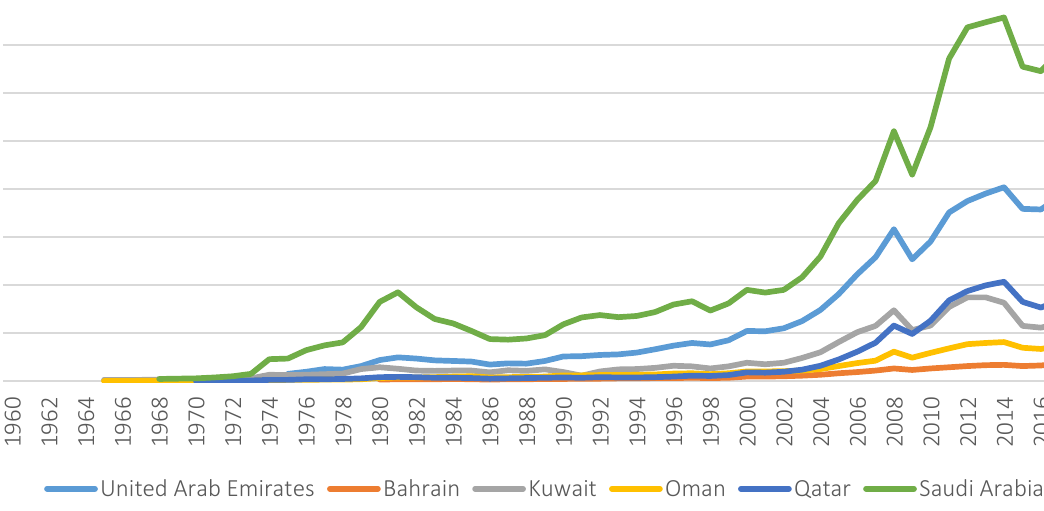
Table 2. Nominal GDP (USD billions)